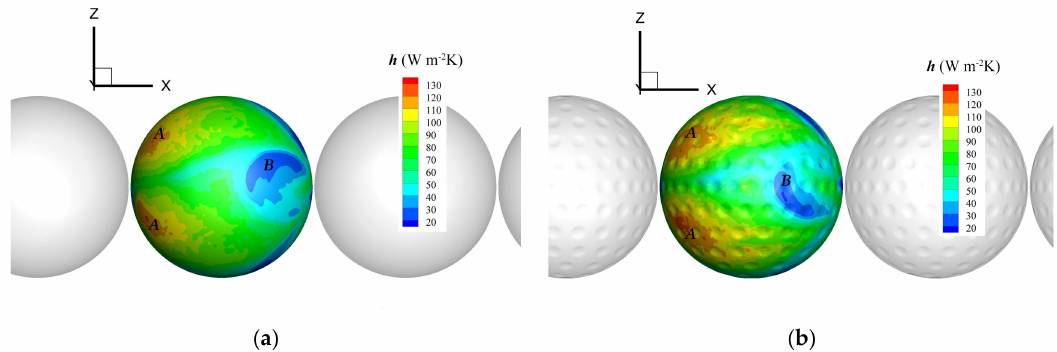
Figure 11. The surface heat transfer coefficient on a smooth or dimpled sphere in packed bed at N = 1.00 ( Re H = 3509) for ( a ) smooth spheres packed bed and ( b ) dimpled spheres packed bed.